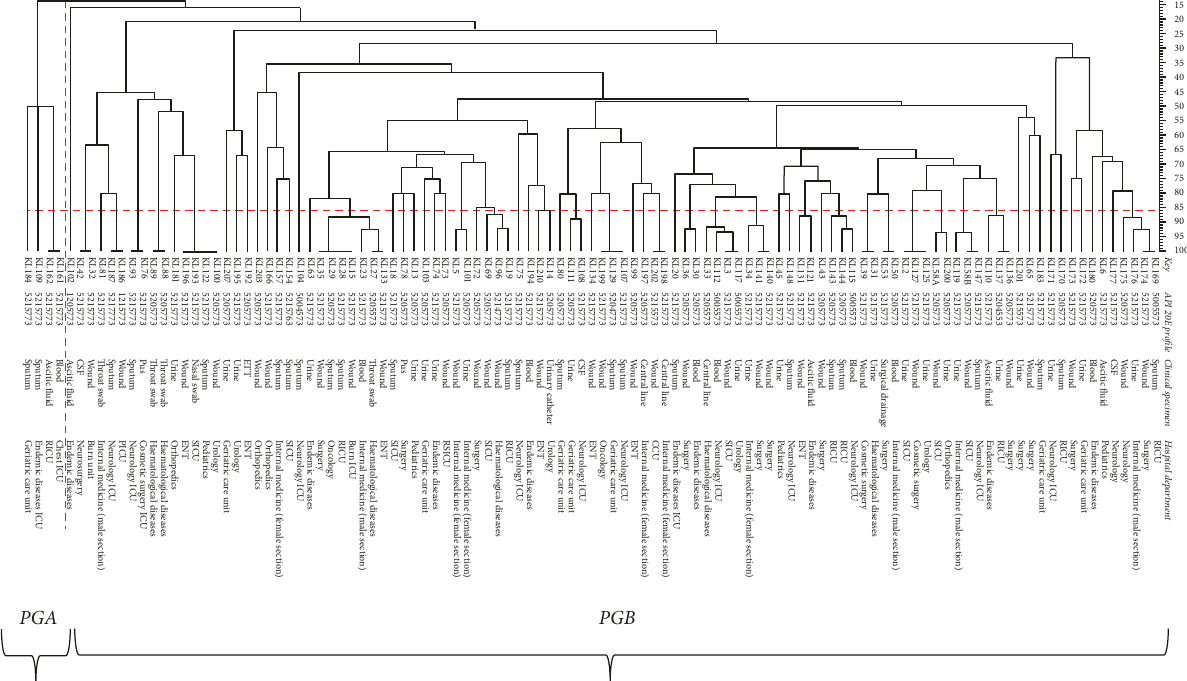
Figure 2: Generated UPGMA dendrogram based on Dice similarity coefficient for clustering of K. pneumoniae isolates using ERIC-PCR as DNA fingerprinting method. KL: Klebsiella pneumoniae , PGA: phylogenetic group A, and PGB: phylogenetic group B.